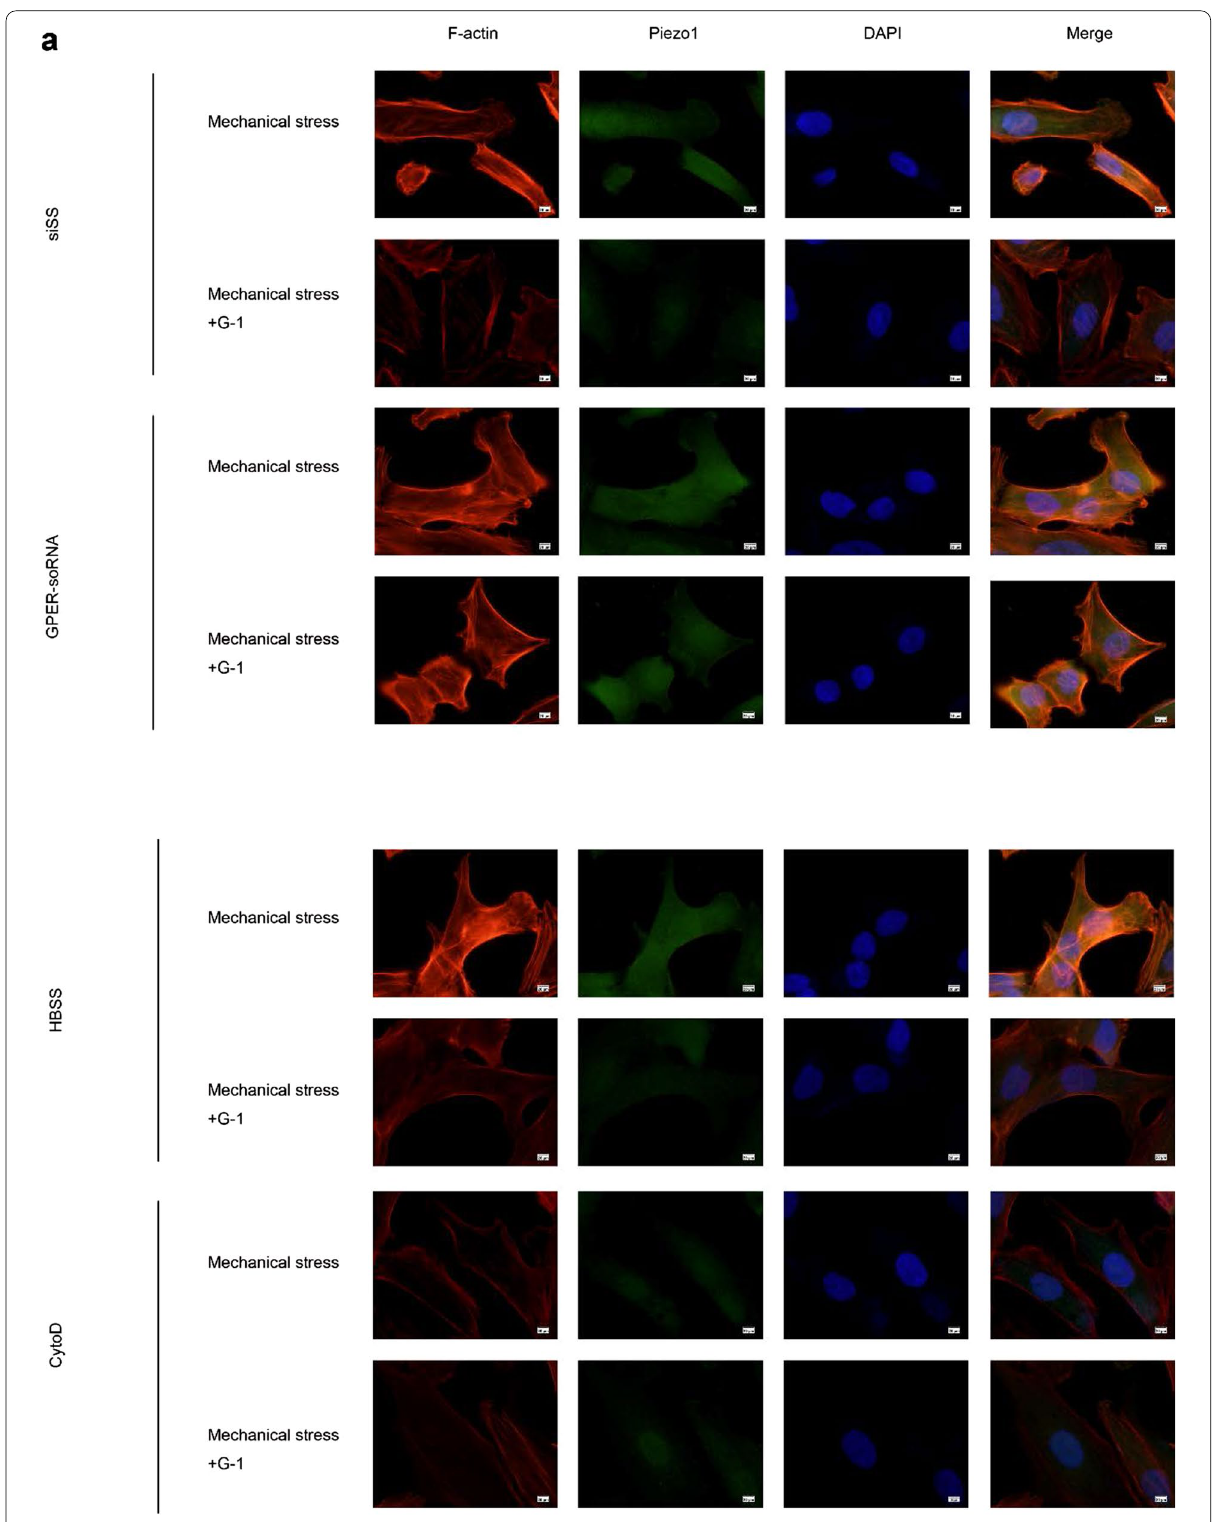
Fig. 4 GPER inhibits mechanical stress-mediated actin polymerization and Piezo1 activation. a Immunofluorescence staining F-actin and Piezo1 (n 3). b Cell viabilities for chondrocytes treated with mechanical stress, 10 μM G-1, and 8 μM cytoD (n = chondrocytes treated with mechanical stress, 10 μM G-1, and 8 μM cytoD (n